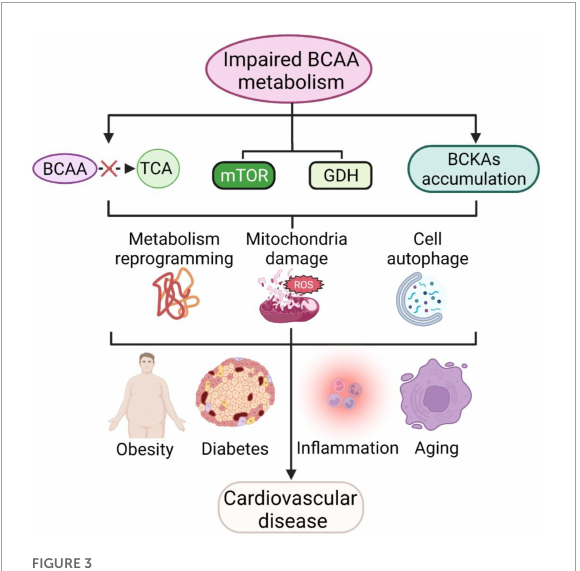
FIGURE3 BCAAs and cardiovascular diseases. Impaired BCAA